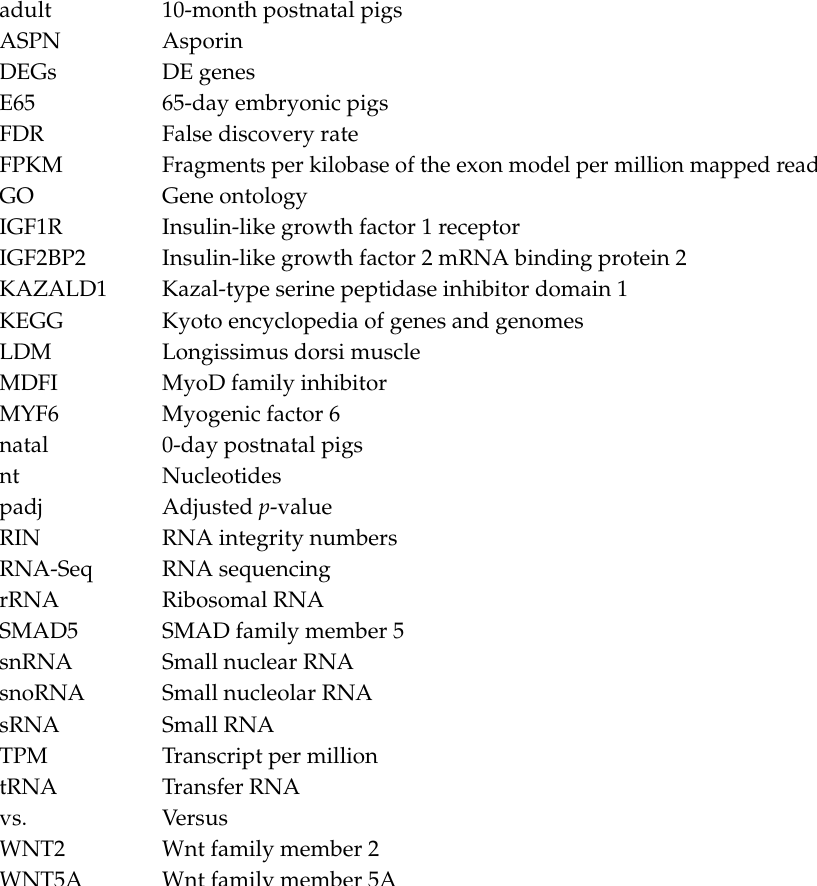
Table S6: The list of all DEGs with their corrected p-value and fold change. Table S7: The miRNA-Seq data filter and mapping summary, Table S8: The ratio of the mapped reads in sRNA libraries, Figure S1: The sequence length distribution of the miRNA in three samples (A: E65, B: natal and C: adult). Figure S2: Top 60 of GO enrichment for DE target genes from three groups of pairwise comparisons, Figure S3: Top 20 of KEGG pathways enrichment for DE target genes from three groups of pairwise